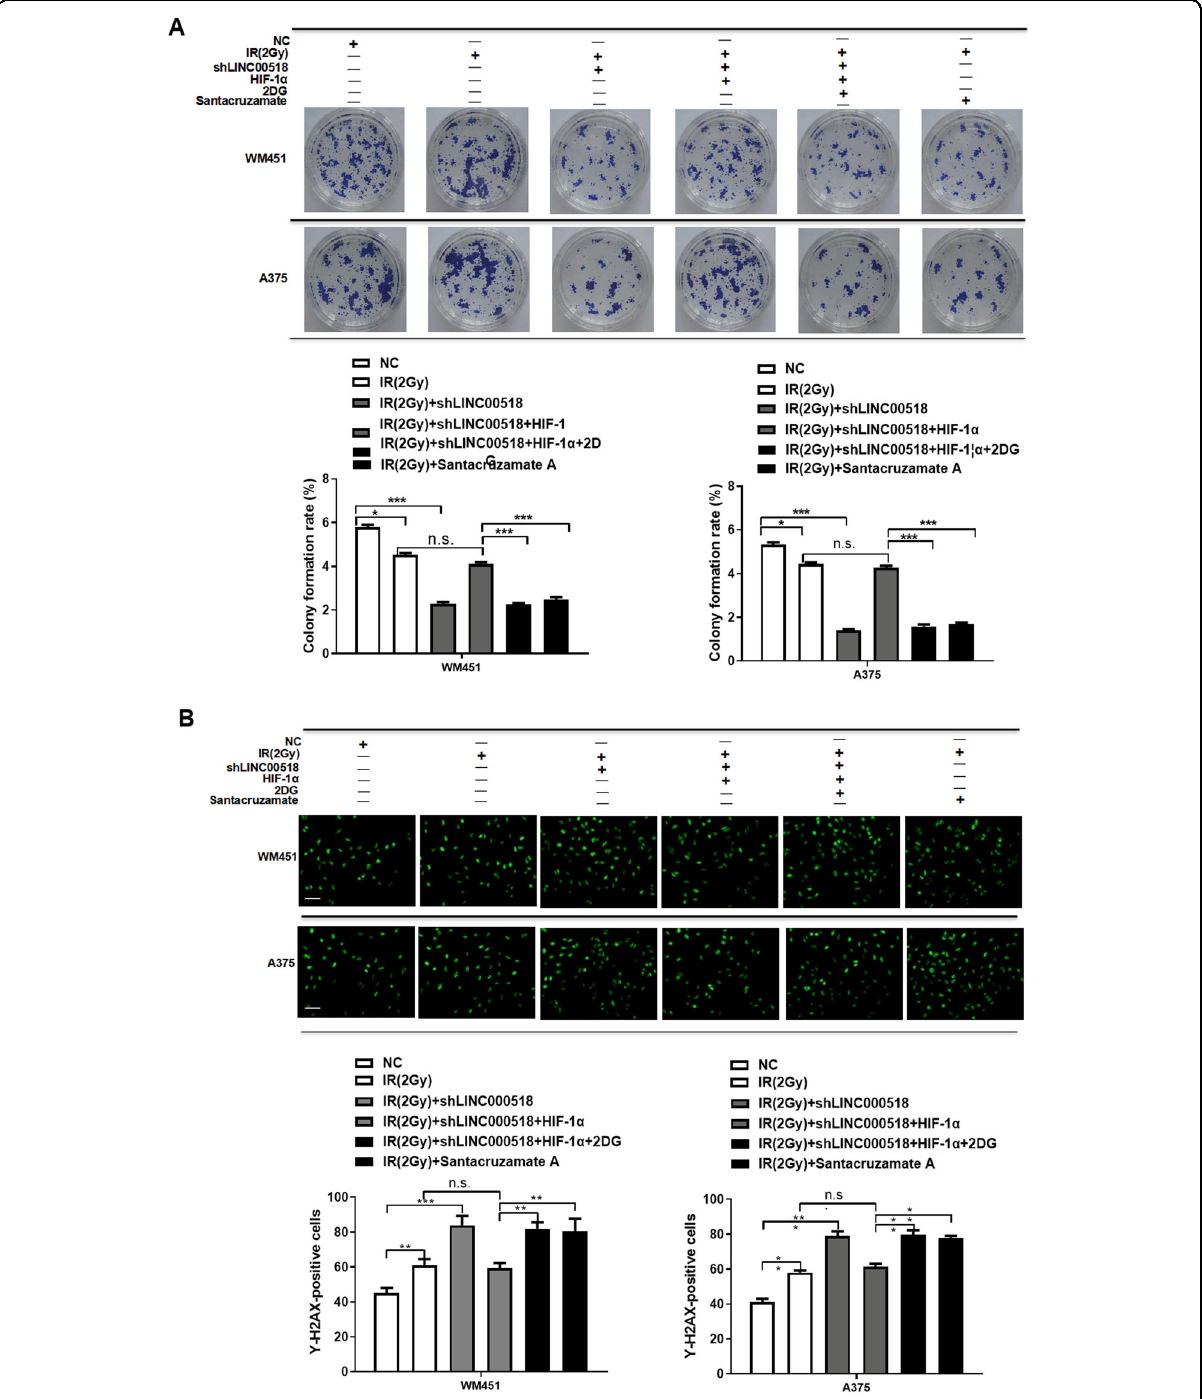
Fig. 7 Involvement of the LINC00518 /miR-33a-3p/HIF-1 α negative feedback loop in glycolysis-mediated radiotherapy resistance of CMM cells. A Colony formation showing that knockdown of LINC00518 expression in WM451 and A375 cells inhibited the invasion and proliferation of CMM cells, increased the radiosensitivity of cells, while overexpression of HIF-1 α reversed this effect. Both 2DG and Santacruzamate A increased radiosensitivity, which was inhibited by HIF-1 α overexpression or by upregulation of LINC00518 and HIF-1 α in the CMM cells. B Immuno fl uorescence assays indicating that knockdown of LINC00518 expression in WM451 and A375 cells could induce structural damage of their nuclei under radiotherapy; however, HIF-1 α could reverse this effect, while 2DG and Santacruzamate A offset the in fl uence of HIF-1 α . The histogram data for each group are an average of three independent replicates; bars indicate SD; * P < 0.05, ** P < 0.01, *** P <